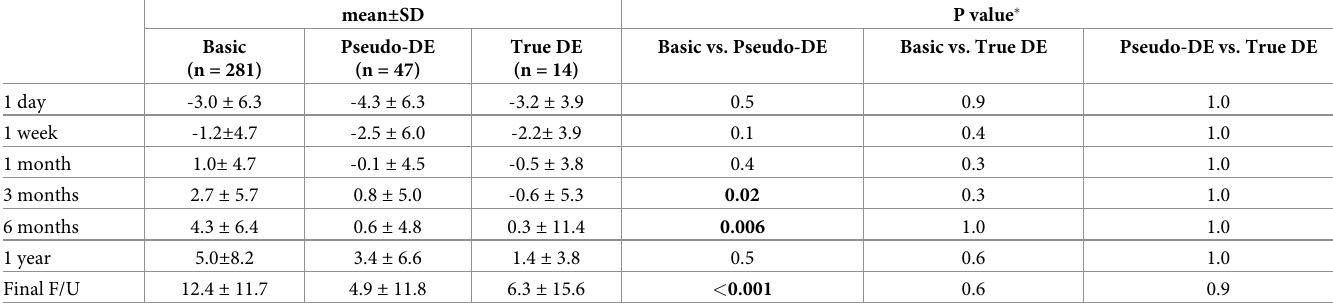
Table 4. Postoperative angles of deviation (PD) at